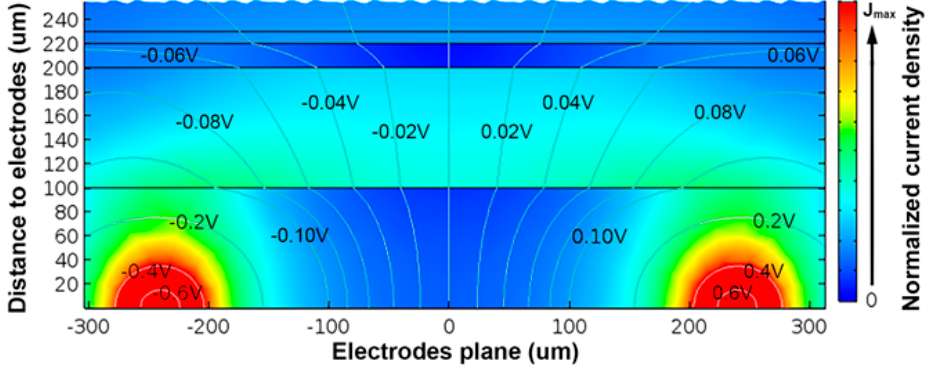
Figure 5. Two-dimensional finite element analysis (FEA) simulation model for the configuration #5 in Table 2. Electrodes were placed on the bottom left and right corners of the image (modeled without thicknesses). The color plane represents the normalized current density, whereas the grey lines are equipotentials (V). Higher current densities near the two electrodes can be